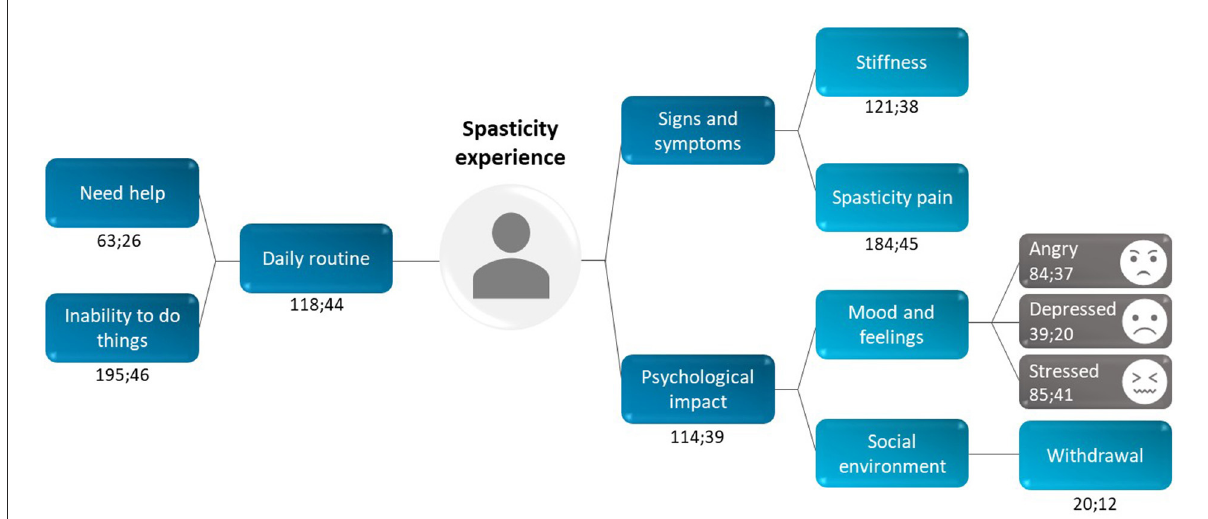
FIGURE7 Patient perception of the overall spasticity experience: data from two interviews (stage 1 and stage 3). Each recurring theme was coded using the following format: x;y, in which x = “total number of times a theme was mentioned” and y = “number of interviews in which the theme was mentioned.” For example, the code for stiffness (121;38) was mentioned 121 times across 38